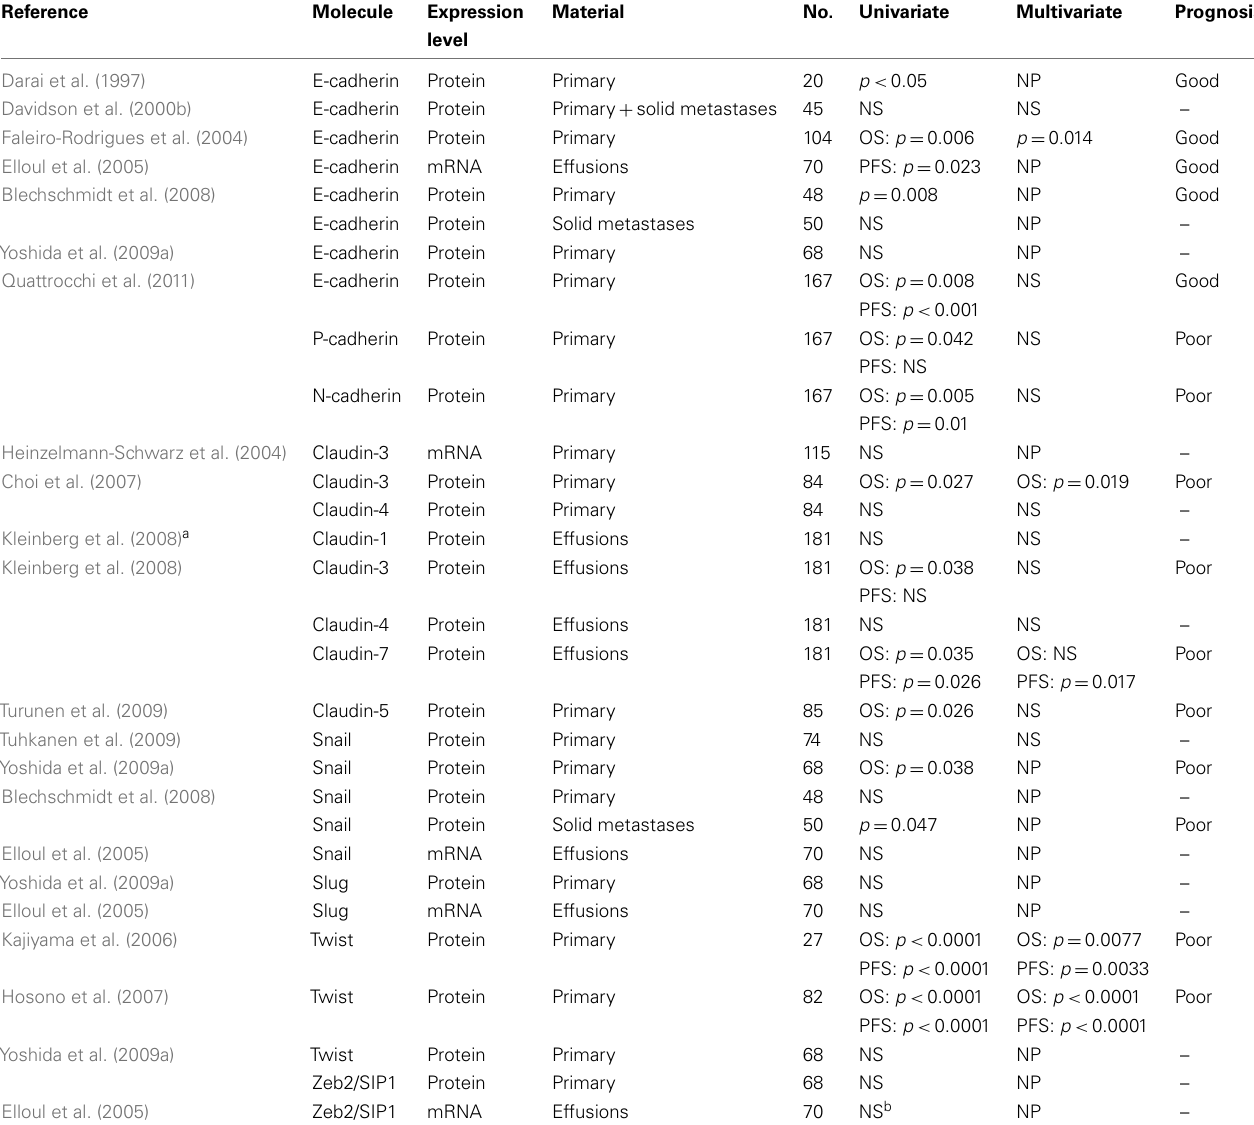
Table 2 | Molecules related to epithelial-to-mesenchymal transition in clinical ovarian carcinoma specimens – prognostic